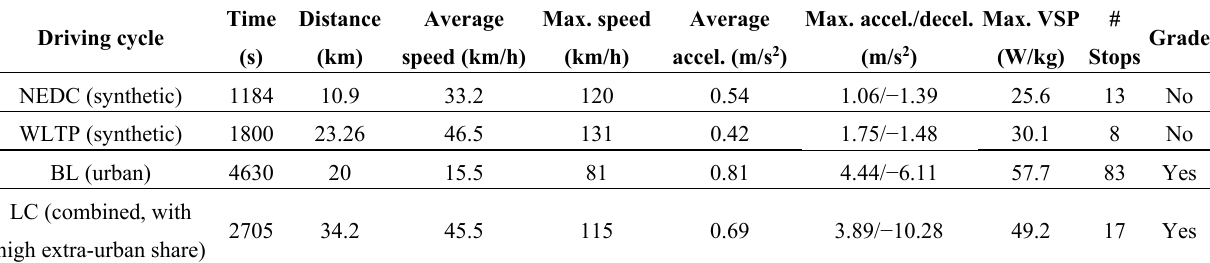
Figure 1. Road grade and speed profile of the real measured driving cycles: ( a ) BL; ( b ) LC. Table 2. Driving cycle